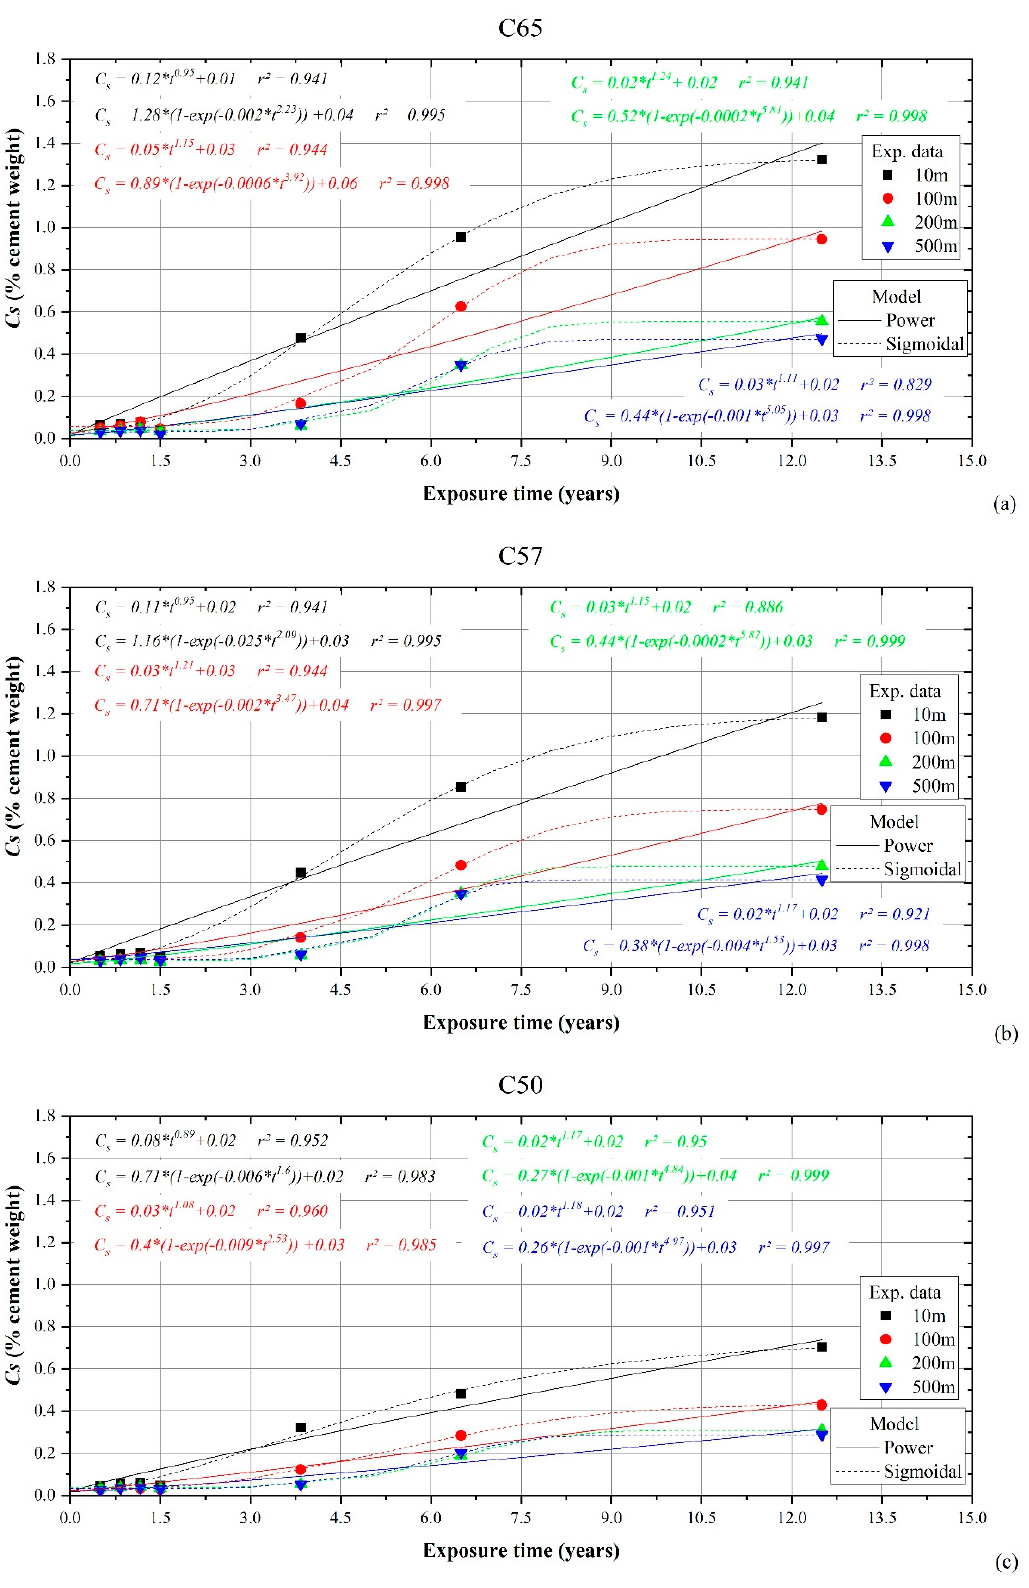
Figure 8. Fitting results with power and sigmoidal functions and Cs data for C65 ( a ), C57 ( b ) and C50 ( c ) concrete. C50 ( c )